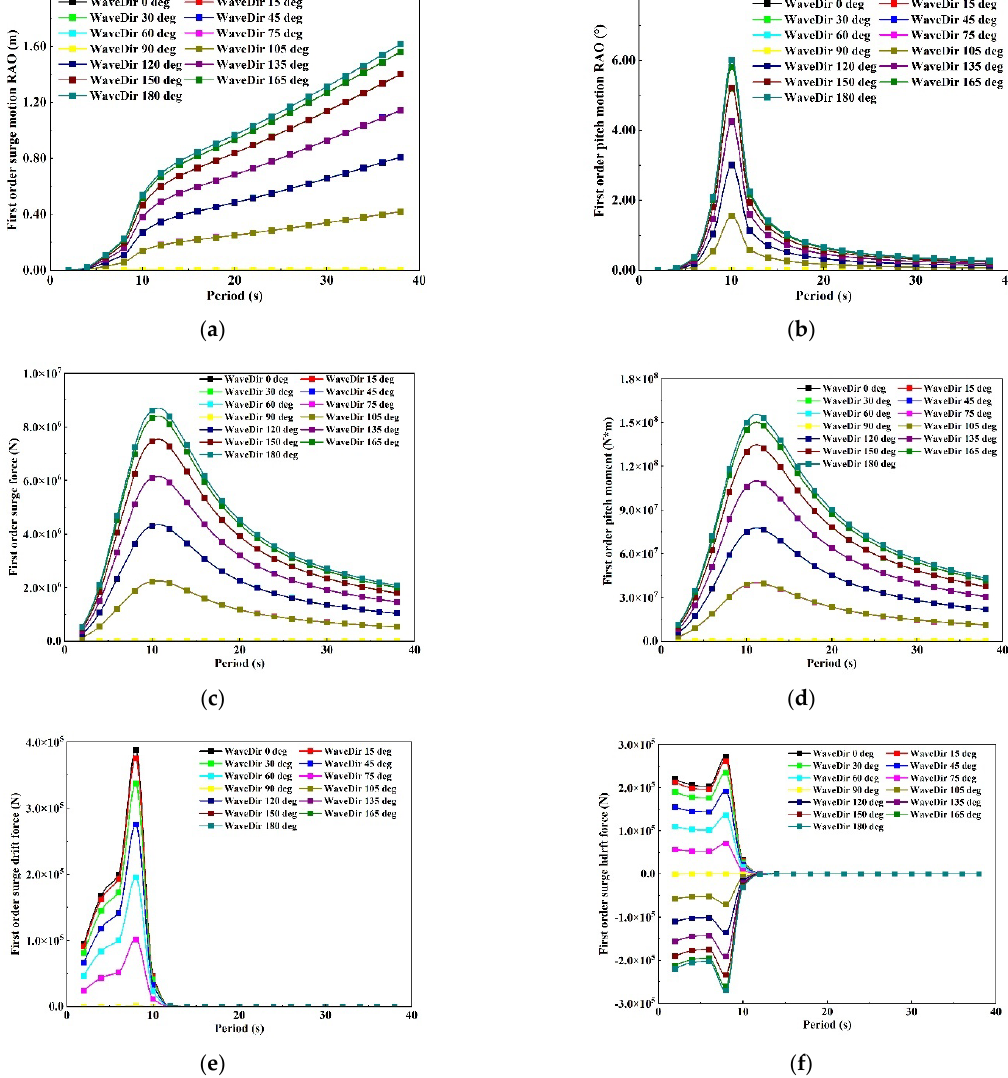
Figure 10. Calculation results of hydrodynamic analysis of the Kulluk platform. ( a ) First-order surge motion transfer function RAO; ( b ) first-order pitch motion transfer function RAO; ( c ) first-order surge force; ( d ) first-order pitch moment; ( e ) mean drift force in the surge by far-field method; ( f ) mean drift force in the surge by direct pressure integral method.